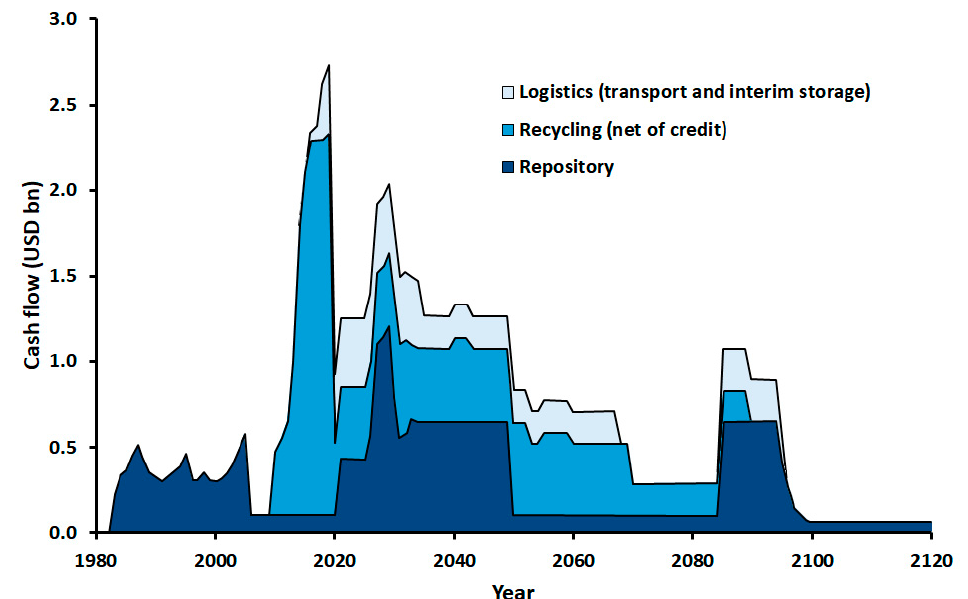
Figure 3. Cash flow profile for the TTC “portfolio” strategy (emplacement in Yucca Mountain in 2030, and acceptance of used fuel begins 2010–2020) [43].